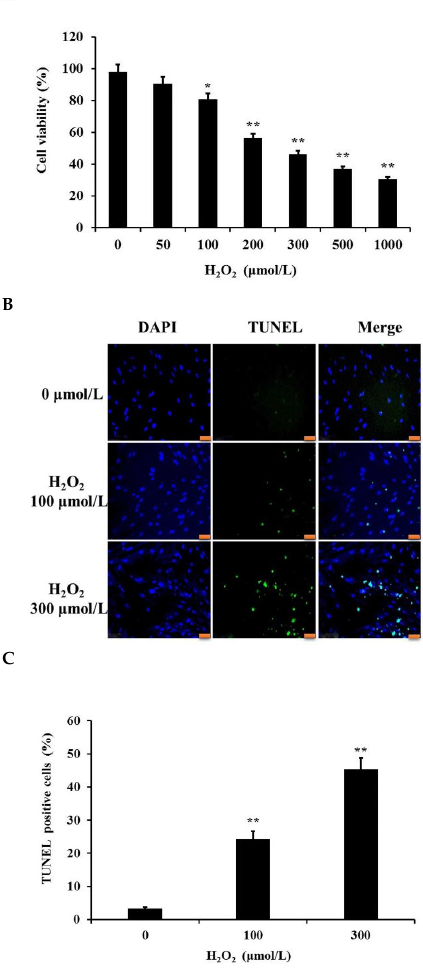
Figure 1. The H 2 O 2 -mediated OS model in PGCs. ( A ) Primary cultured GCs were treated with different concentrations of H 2 O 2 for 12 h. The CCK-8 assay was used to determine GC viability. ( B ) GC apoptosis was determined via TUNEL analysis; scale bars correspond to 50 µ m. ( C ) The average number of TUNEL-positive nuclei/visual fields was used to quantify GC apoptosis. Data represent mean ± S.E.; each group: n = 3. * p < 0.05, ** p < 0.01 compared to control group.